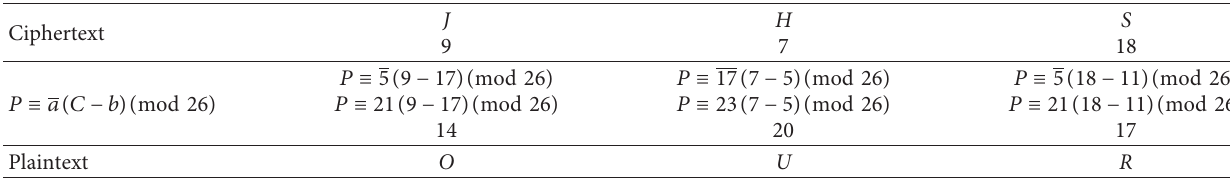
Table 7: Solution on the evaluated affine transformation, P ≡ a ( C − b )( mod 26 ) .